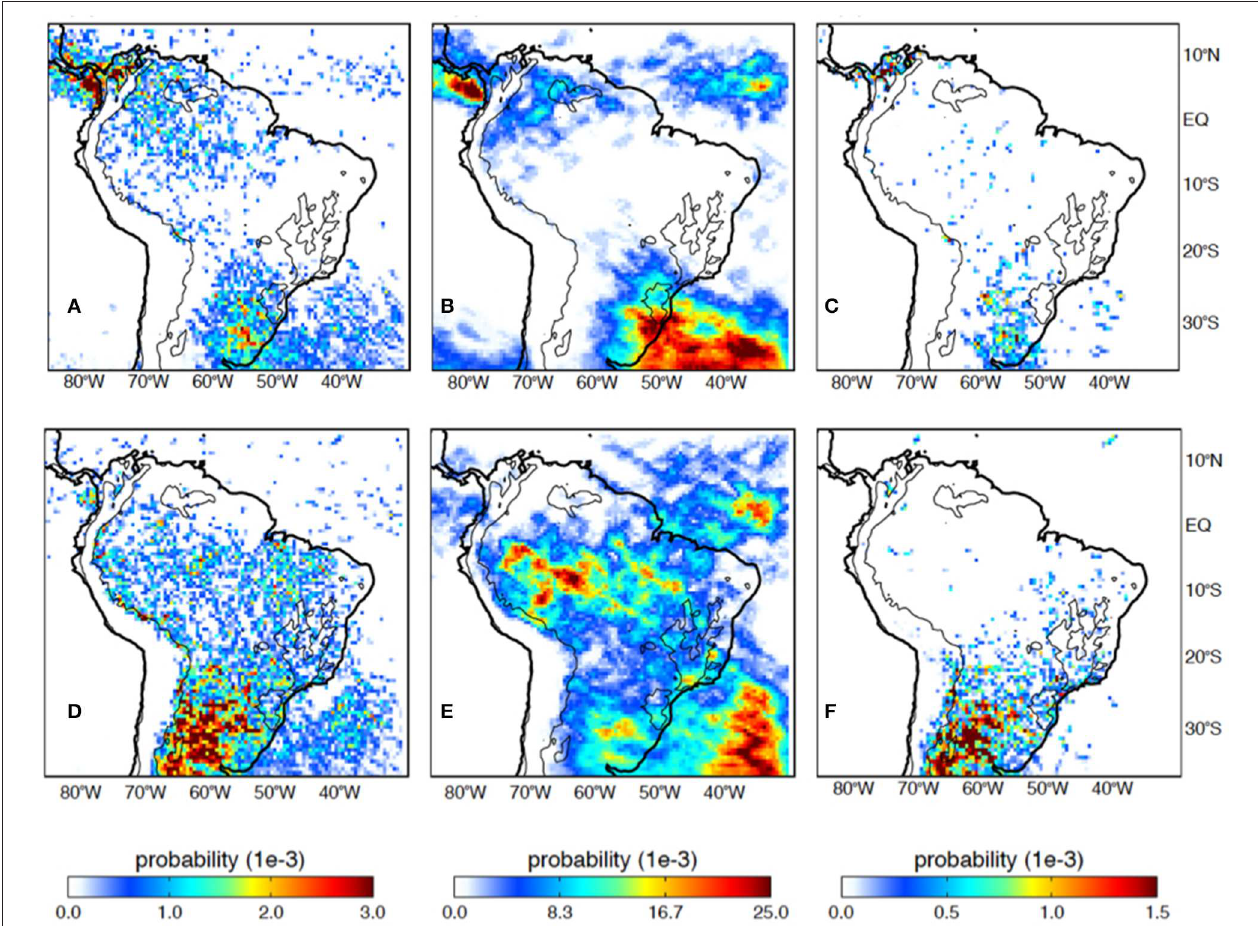
FIGURE 5 | Geographical distribution of the probability of finding (A) a wide convective core; (B) a broad stratiform region; and (C) a deep convective core during the months of JJA from 1998 to 2003. (D) same as (A) ; (E) same as (B) ; and (F) same as (C) but for DJF, respectively. The black contour inside the continental regions represents the 700 m elevation. Figure adapted from Zuluaga and Houze